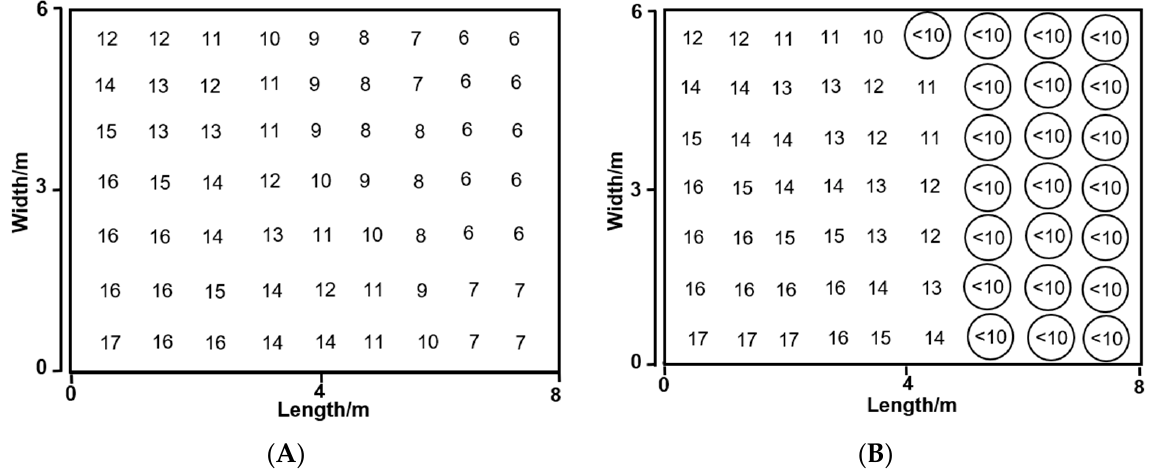
Figure 11. Grid-specific UGR values on a 1.2 m horizontal plane with a view angle of 30° calculated by the ( A ) developed program and ( B ) DIALux. Table 7. Values of design parameters obtained from the developed program and DIALux.